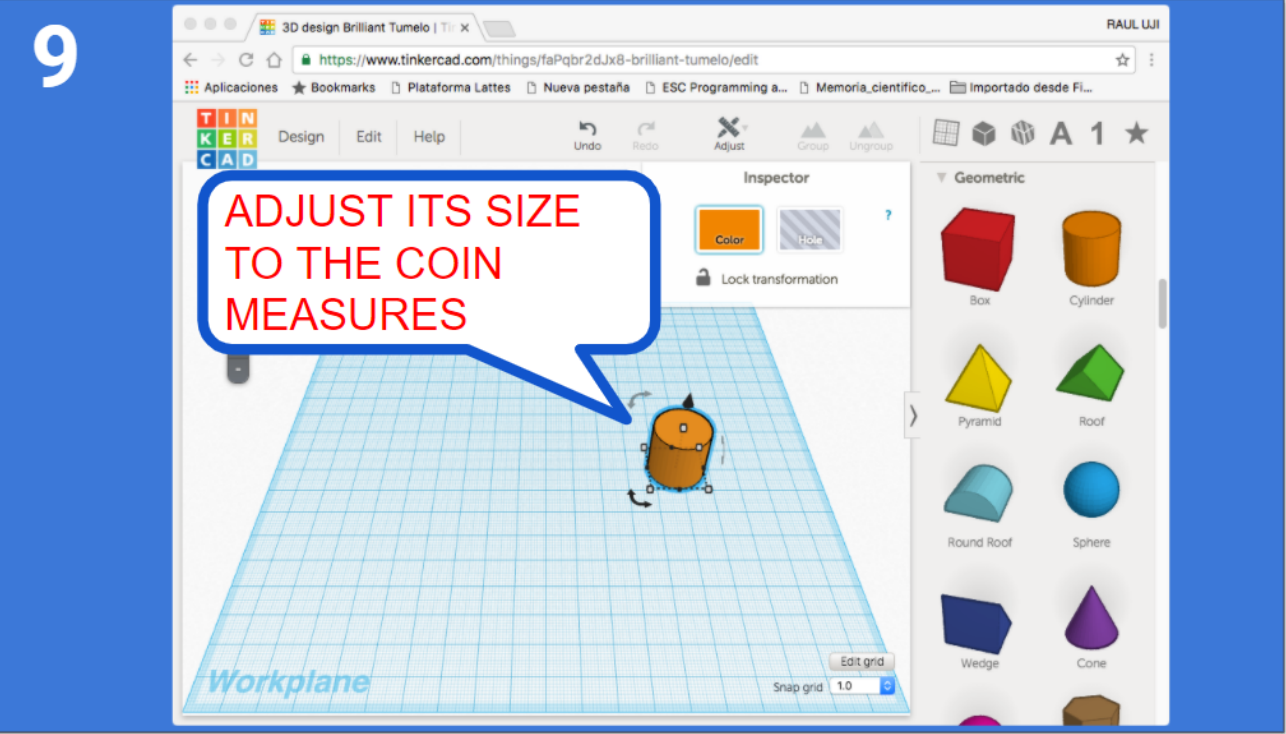
Figure 7. Example of orientations given to the high-school students to introduce the 3D tools